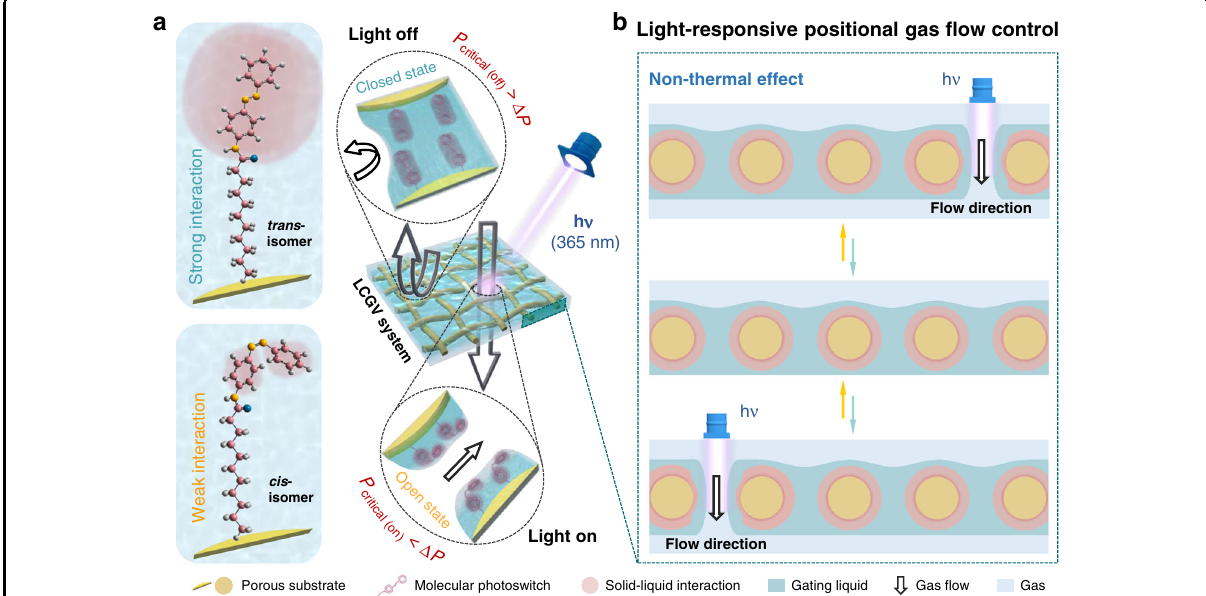
Fig. 1 Working principle and non-thermal effective positional gas fl ow control of the light-responsive and corrosion-resistant gas valve (LCGV). a Schematic diagram of the closed and open states of LCGV system. The reversible photoisomerization of molecular photoswitches induces a change in the solid – liquid interaction between the solid porous substrate and functional gating liquid 36 , which further causes the variation of the substantial gas critical pressures of the LCGV system. b Gas fl ow can be precisely navigated and dynamically controlled without thermal interference by LCGV system due to the athermal interaction and high spatiotemporal resolution of UV